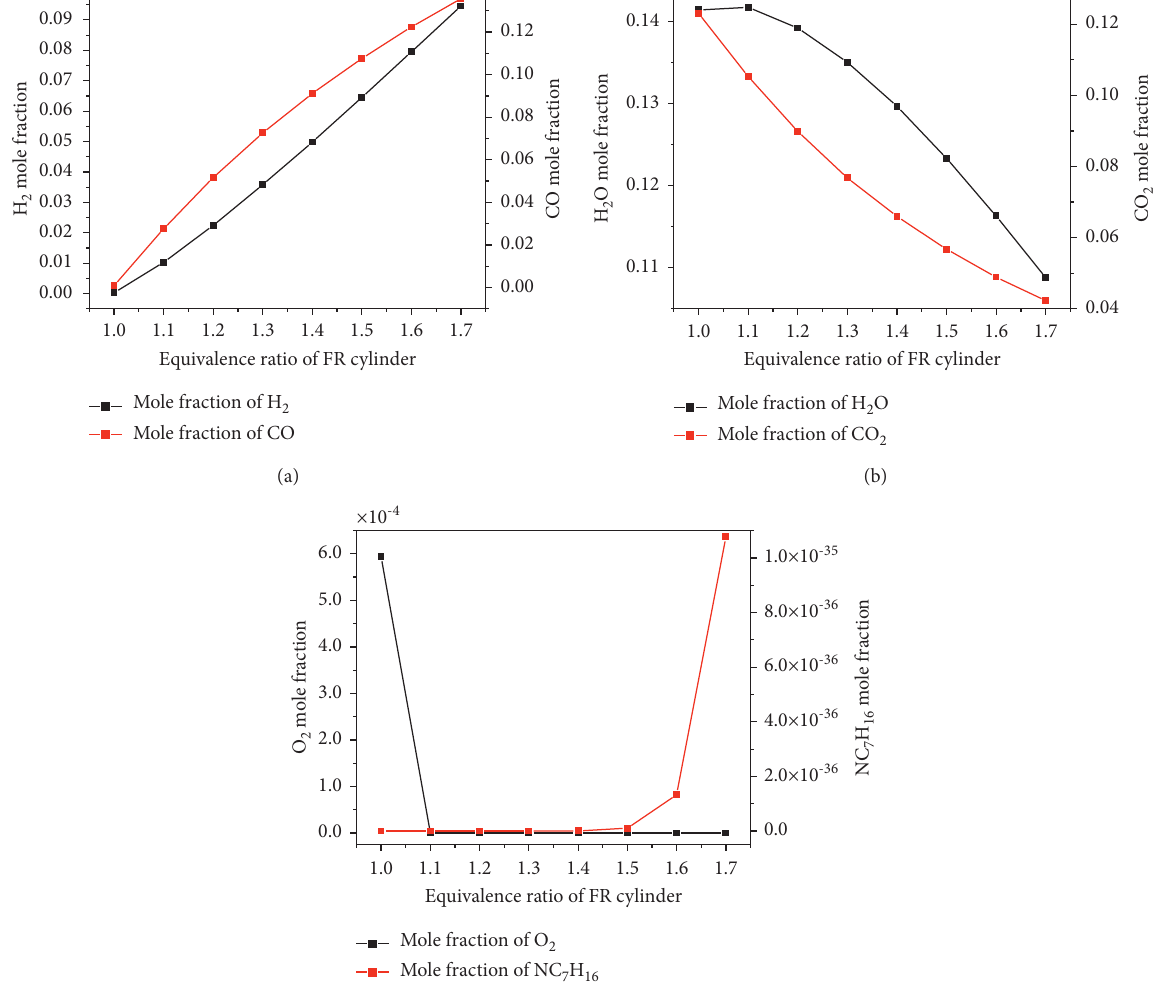
2 , CO, CO 2 , H 2 O, O 2 , and n-heptane at different n-heptane equivalence ratios for the HCCI engine at 125